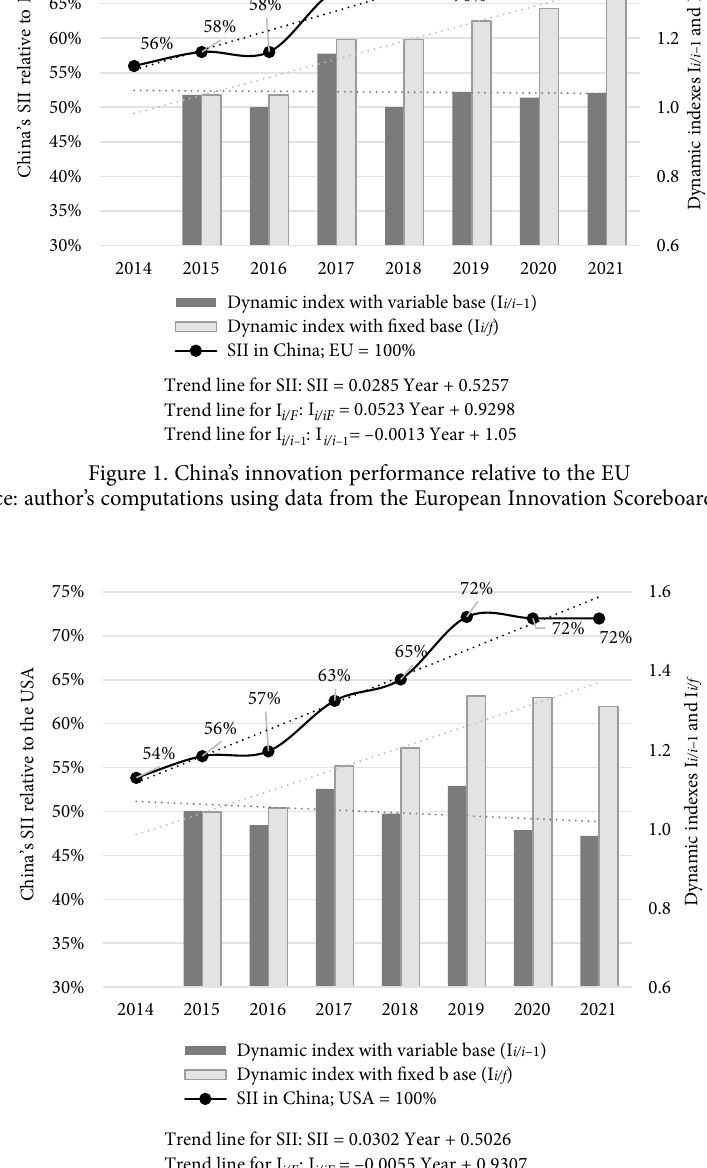
Dynamic index with variable base (I i/i –1 ) Dynamic index with fixed b ase (I i/f ) SII in China; USA = 100% Trend line for SII: SII = 0.0302 Year + 0.5026 Trend line for I i/F : I i/iF = –0.0055 Year + 0.9307 Trend line for I i/i –1 : I = 0.0073 Year + 1.0774 i/i Figure 2. Innovation performance of the Chinese economy relative to the USA (source: author’s computations using data from the European Innovation Scoreboard 2021)